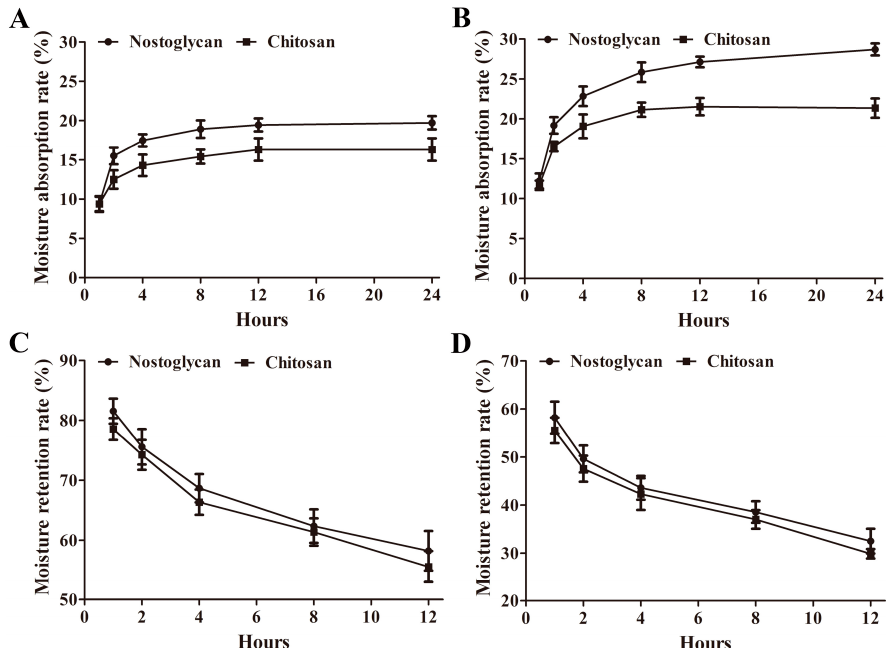
Figure 2. Moisture absorption and retention rates of nostoglycan. For moisture absorption analysis, the dried polysaccharides were placed at 43% ( A ) or 81% ( B ) RH for the indicated times. For moisture retention determination, the humidified polysaccharides were first placed at 43% RH for 12 h ( C ) and then in a silica gel chamber for the indicated times ( D ). Both moisture gain and loss were determined gravimetrically. Data are representative of three independent experiments and shown as mean ± SD.